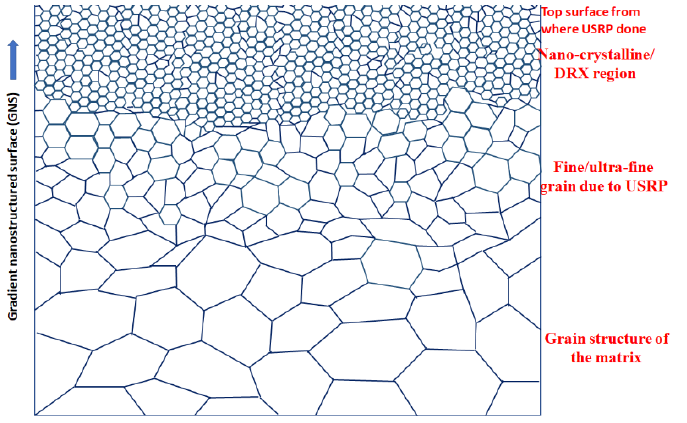
Figure 3. Schematic presentation of microstructure generated during the USRP